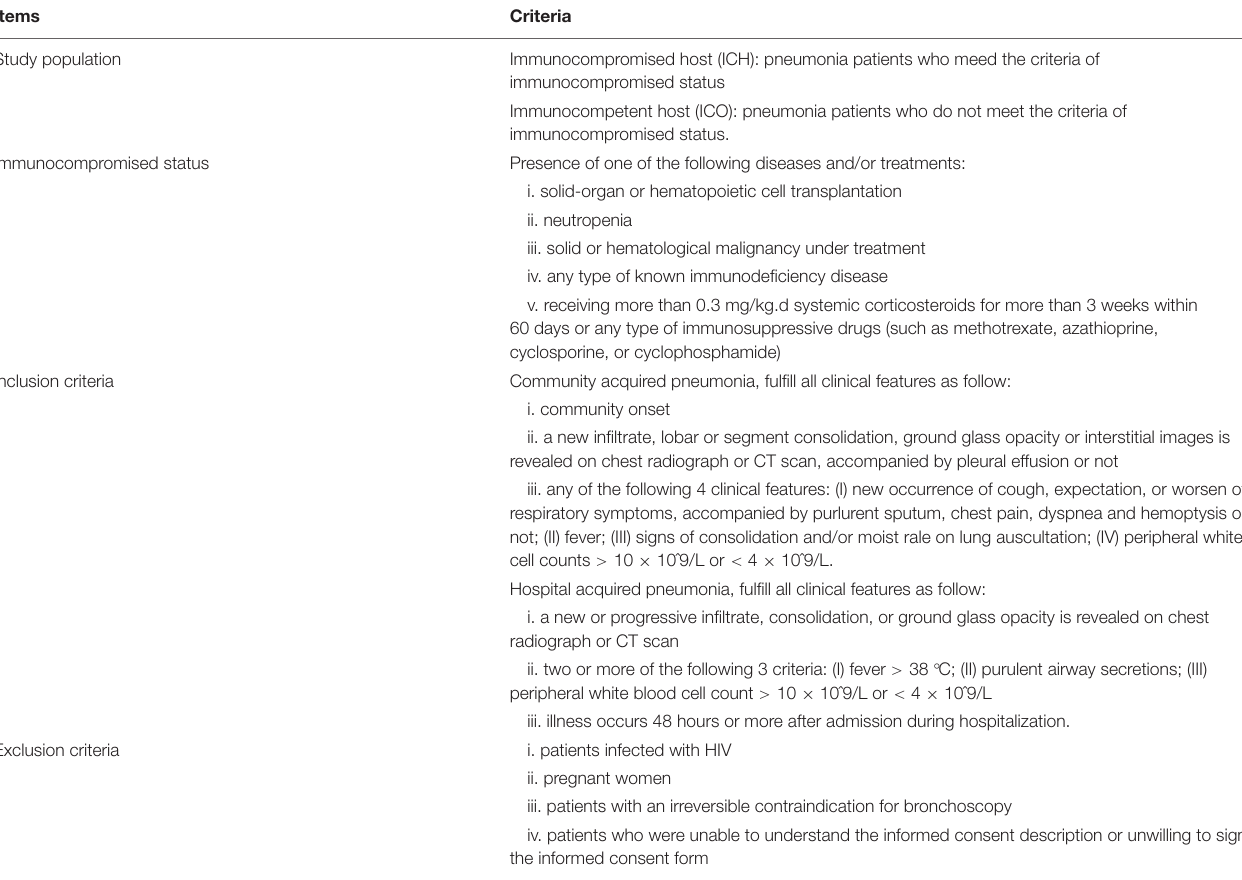
TABLE 1 | Definition of the study population.